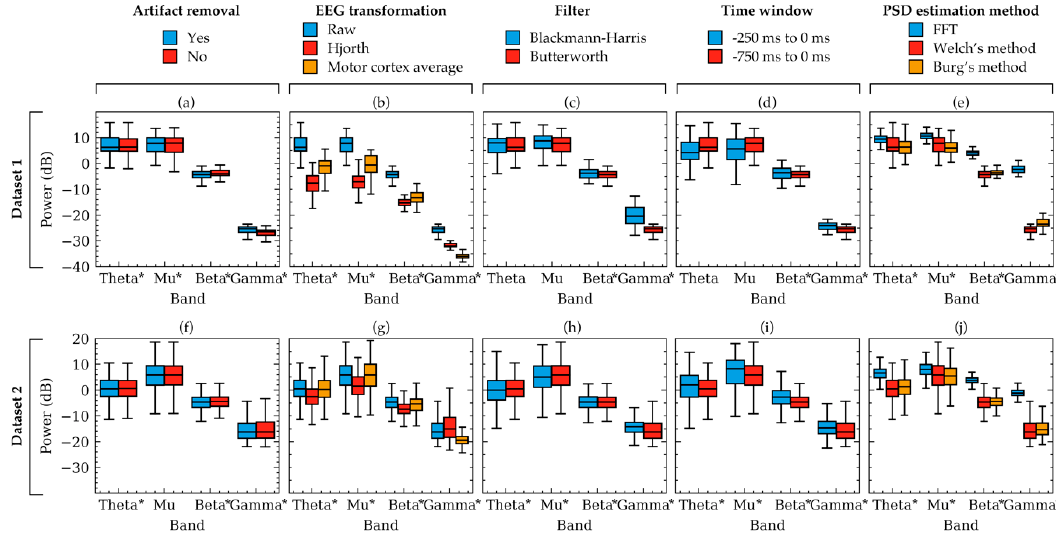
Figure 4. Box plots showing example power variation within two subjects. The variations occurred due to the selection of choices available in artifact removal ( a , f ), EEG transformation ( b , g ), filter ( c , h ), time-window ( d , i ), and PSD estimation method ( e , j ). Powers were computed from the EEG signals of two random subjects from Dataset 1 ( a – e ) and Dataset 2 ( f – j ), respectively. Each subfigure represents the effect of choices available in a factor for the subject. The other factors were kept constant as follows: artifact removal = yes, EEG transformation = raw, filter = Butterworth, time window = 750 ms, method = Welch’s method. The boxes indicate the quartiles of the samples while the whiskers extend to show the rest of the distribution up to 1.5 inter-quartile range. Significant models from Table 1 are indicated in the figure using asterisks (*) near the frequency band names.